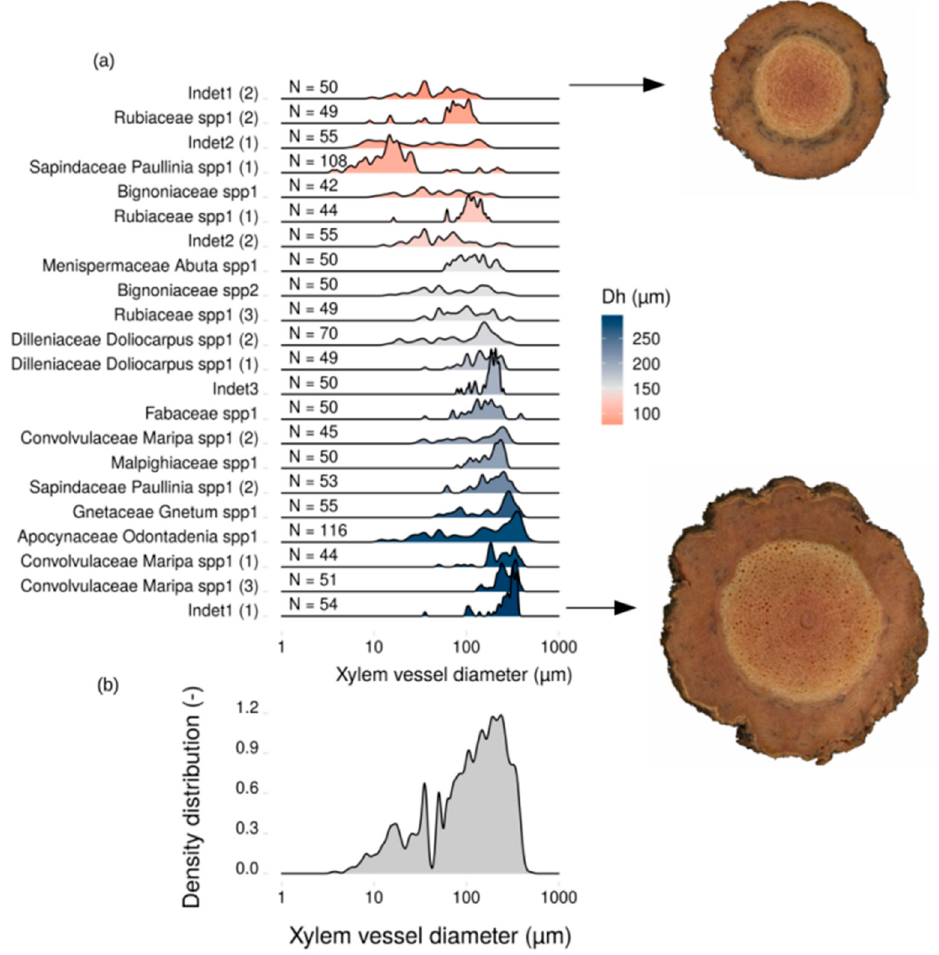
Figure 1. Vessel diameter frequency distribution of the 22 liana individuals ( a ) and of the whole liana dataset ( b ). In ( a ), lianas were sorted by their hydraulic diameter D h (increasing from top to bottom) and the values of N indicate the number of measured xylem vessel diameters for each individual. The two most extreme lianas (in terms of D h ) are illustrated by their cross-sections (scaled by their respective DBH, see Table 1). The numbers in parentheses are subjective identifiers which distinguish individuals from the same morpho-species.